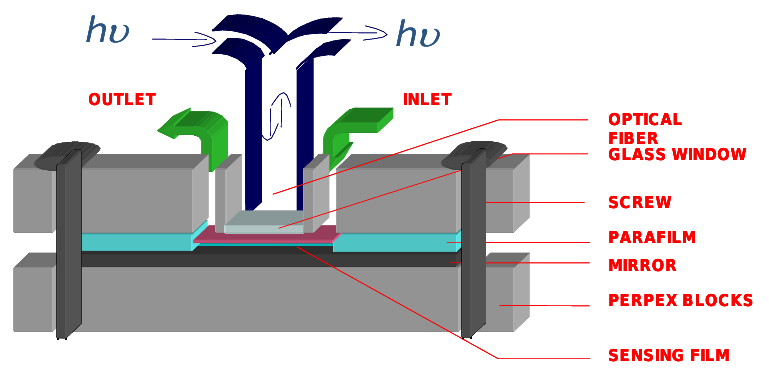
Figure 3. Schematic representation of the flow-through